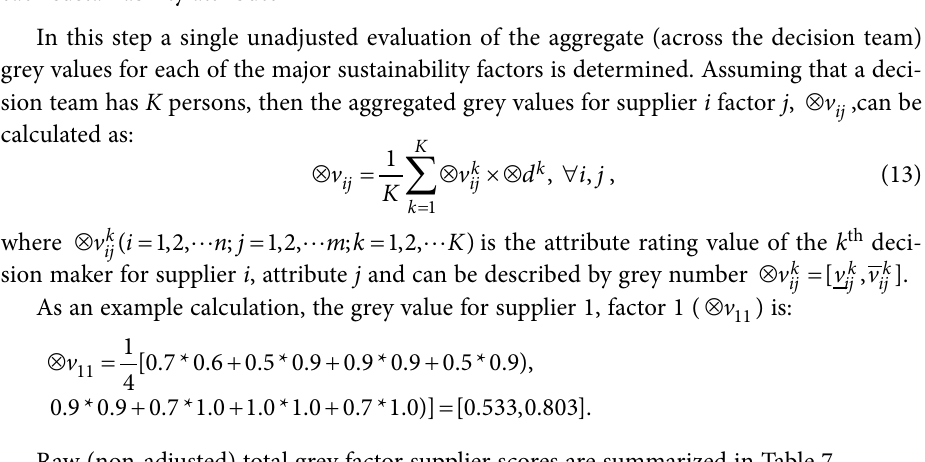
Step 5: Calculate unadjusted aggregated grey values performance levels of suppliers for each sustainability attribute